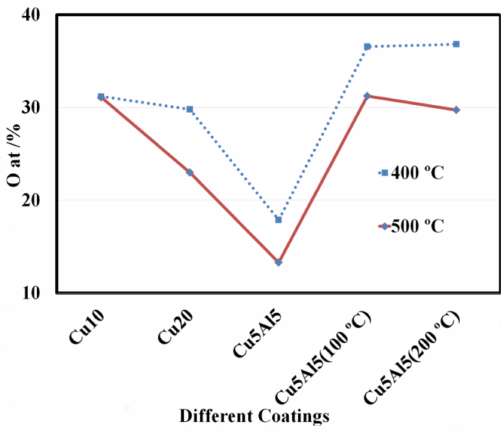
Figure 11. Atomic percentage of oxygen in wear tracks of the coatings annealed at 400 ◦ C and 500 ◦ C.